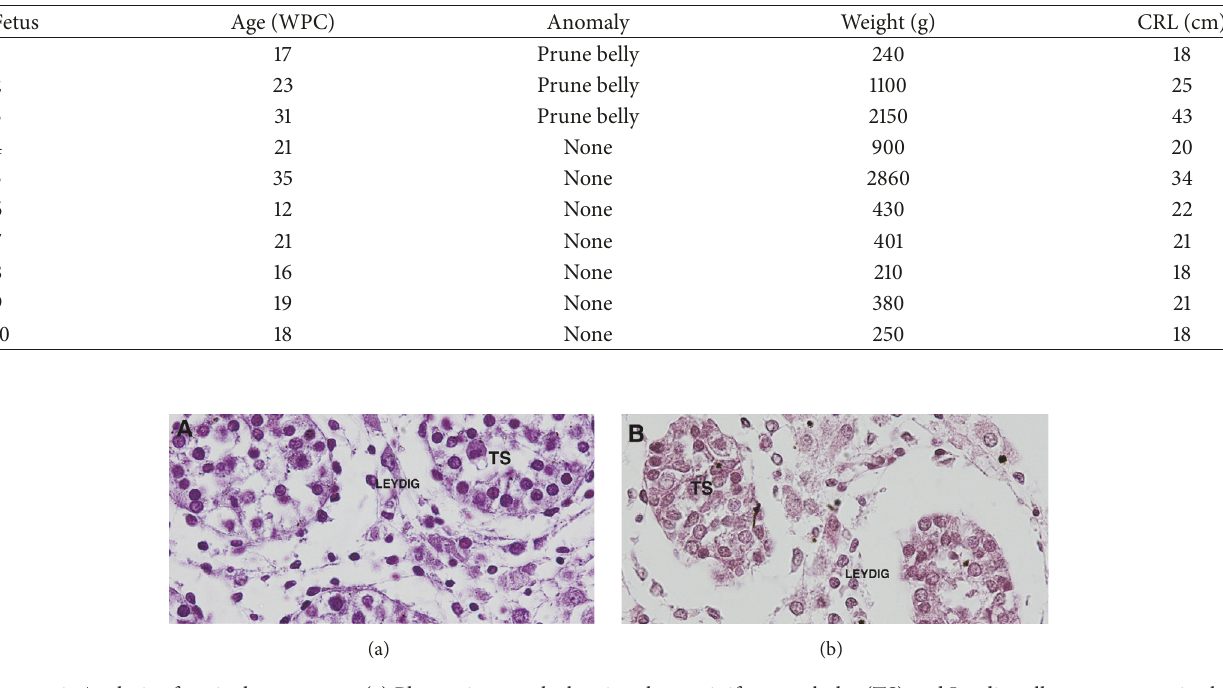
Figure 2: Analysis of testicular structure. (a) Photomicrograph showing the seminiferous tubules (TS) and Leydig cells arrangement in the control group. Fetus with 21 WPC. HE × 400. (b) Photomicrograph showing the seminiferous tubules (TS) and Leydig cells arrangement in prune belly group. Fetus with 31 WPC. HE ×